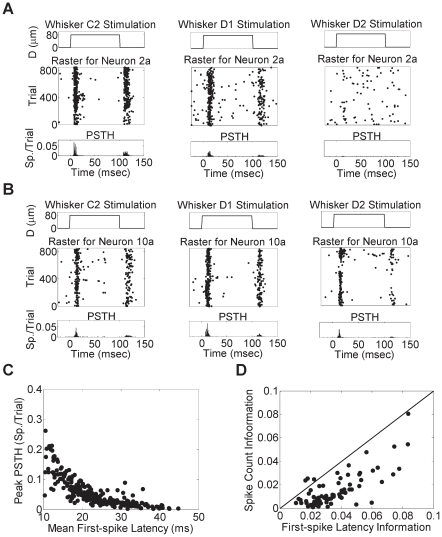
Firing characteristics of the recorded neurons.Two sample neurons: (A) Neuron 2a and (B) Neuron 10a from rat R2 response to stimulation of whiskers C2, D1 and D2. (Top) Whisker displacement. (Middle) Spike raster over multiple repeated trials. (Bottom) Post-stimulus Time Histogram (PSTH) with 0.5ms bin size. Neuron 2a shows stronger and faster response to whisker C2 than other whiskers while Neuron 10a shows a slightly stronger and faster response to whisker D1. (C) Peak PSTH counts of each neuron for each whisker versus its mean first-spike latency (n = 240). Each dot corresponds to the response of a single neuron to a single whisker. (D) Normalized mutual information between spike count/first-spike latency and whisker identity. Each dot corresponds to one neuron. Black diagonal line represents equal mutual information (n = 80).